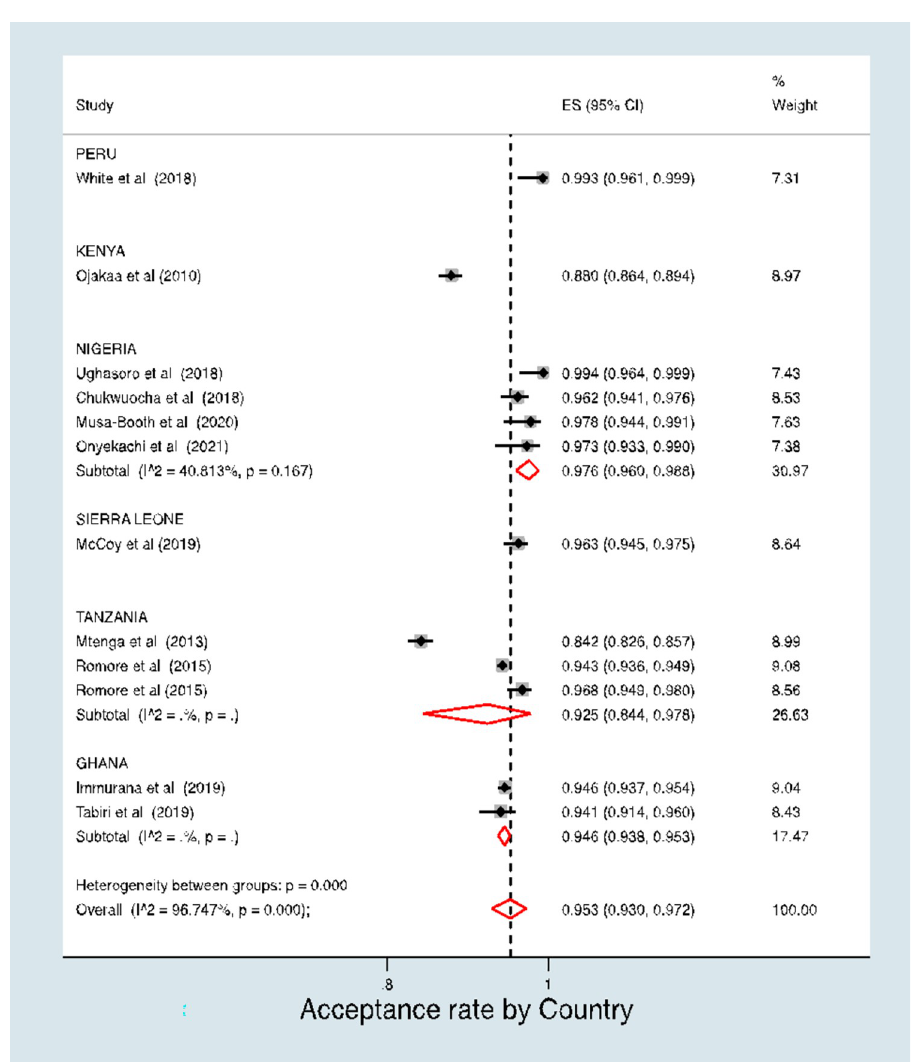
Fig 5. Acceptance malaria vaccine by country of